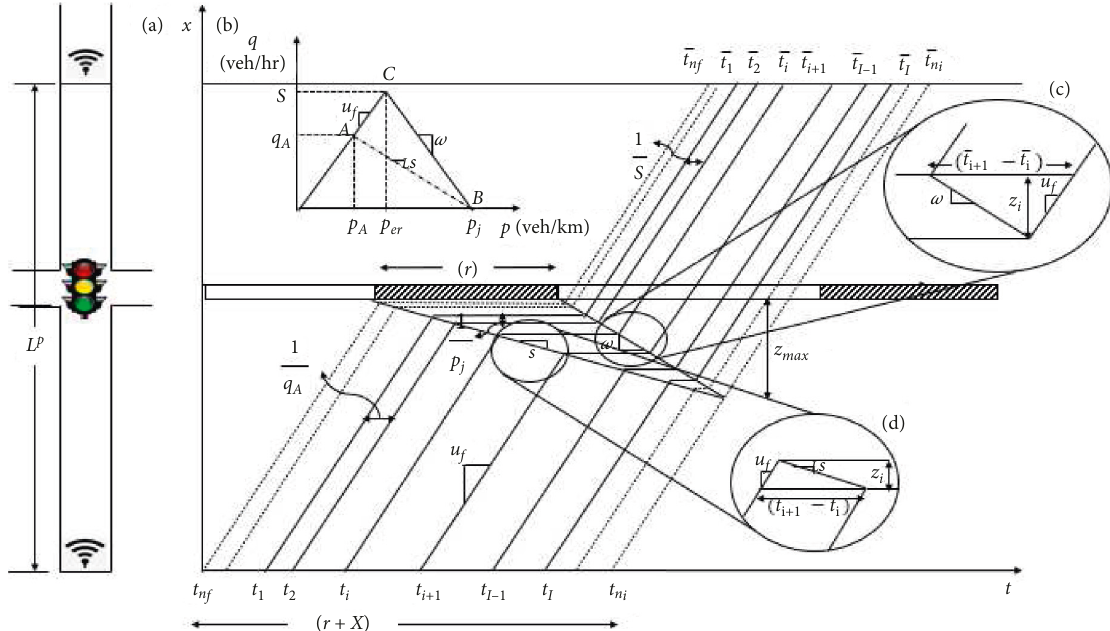
Figure 3: (a) ( x − t ) plot of vehicles travelling from upstream to downstream location. (b) Triangular fundamental diagram. (c) Zoomed-in section of queue discharging process of probe vehicles. (d) Zoomed-in section of queue joining process of probe